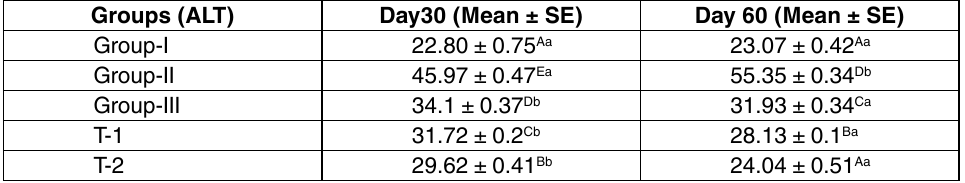
table 4. The mean ± SE ALT (IU/L) values in different treatment groups.